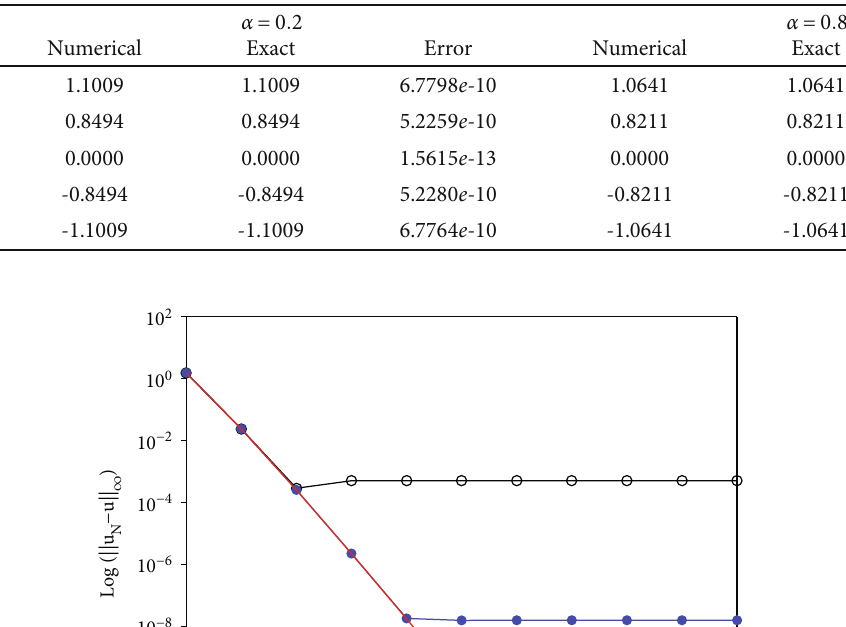
Table 4: Numerical and exact solutions of Equation (24) and absolute errors when M = 12 and N = 1 6 .